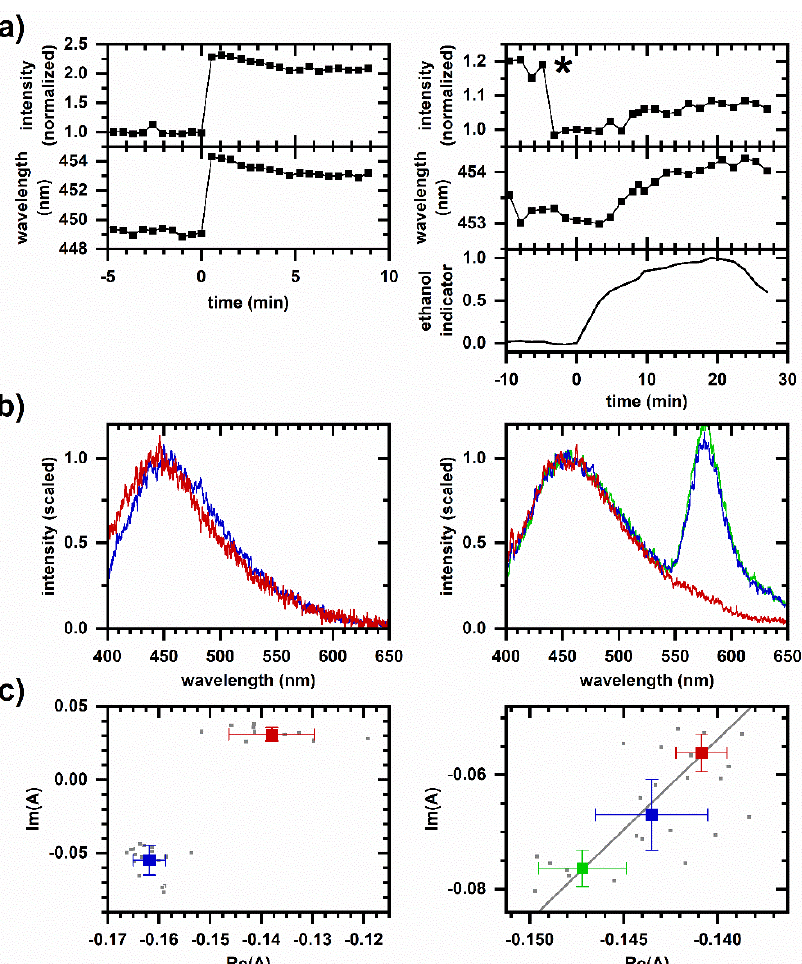
Figure 5. Cellular autofluorescence response to ethanol at ambient pressure. Left column, 2 vol% ethanol, in spectroscopic cuvette. Right column, 10 vol% ethanol, in a microperfusion system. Representative responses are shown; behavior is reproduced on N independently prepared samples, N > 50 in a cuvette and N = 3 in the microperfusion system. ( a ) Autofluorescence intensity and average emission wavelength versus time. Spectrally integrated autofluorescence intensity is normalized to the intensity averaged over 10 min prior to ethanol introduction. Autofluorescence wavelength is calculated as an intensity-weighted average emission wavelength. Time is shifted so that ethanol is introduced to the sample at t = 0 min. For the microperfusion data, 1 µM rhodamine is added to the reservoir as an ethanol indicator; shown is the integrated emission intensity for pixels 675–725 (572–585 nm wavelength) scaled to be between 0 and 1. The sudden drop in intensity at (*) is an artifact of sample movement within the capillary chamber. ( b ) Representative emission spectra. Red—Prior to ethanol introduction; blue—10 min after ethanol introduction; green—20 min after ethanol introduction. Spectra are scaled to minimize least-square difference. For the cuvette data, a 20 min spectrum (green) is not shown because the emission reached a steady value within the first 5 min. For the microperfusion data, the peak at 575 nm wavelength is due to the rhodamine indicator. ( c ) Phasor plots. Small symbols are phasors calculated from individual measurements. Large symbols are average and standard deviations of phasor values. Color corresponds to time intervals over which phasor values are averaged: red—10 min prior to ethanol introduction; blue—First 10 min after ethanol introduction; green—Second 10 min after ethanol introduction. The gray line is a linear least-squares fit to the large symbols. Intensity, average emission wavelength, phasor, and least-square minimization are calculated from a measured spectrum using the first 400 pixels (400–500 nm wavelength).